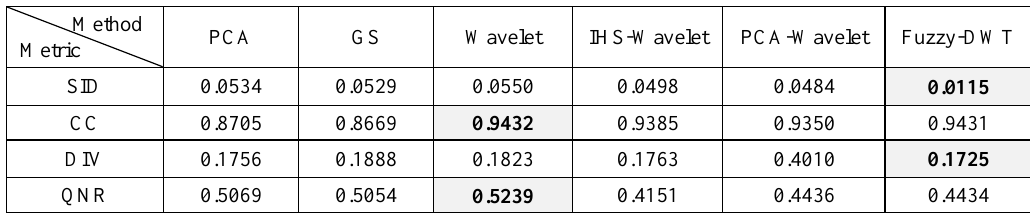
Table 2: Results of the spectral quality assessment of six pan-sharpening